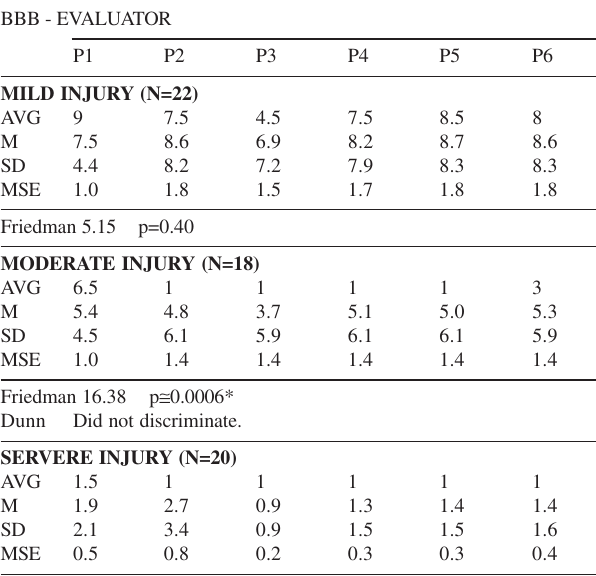
Table 2 - Interevaluator comparison using the friedman test and discrimination using the multiple comparison test modified by dunn. BBB -